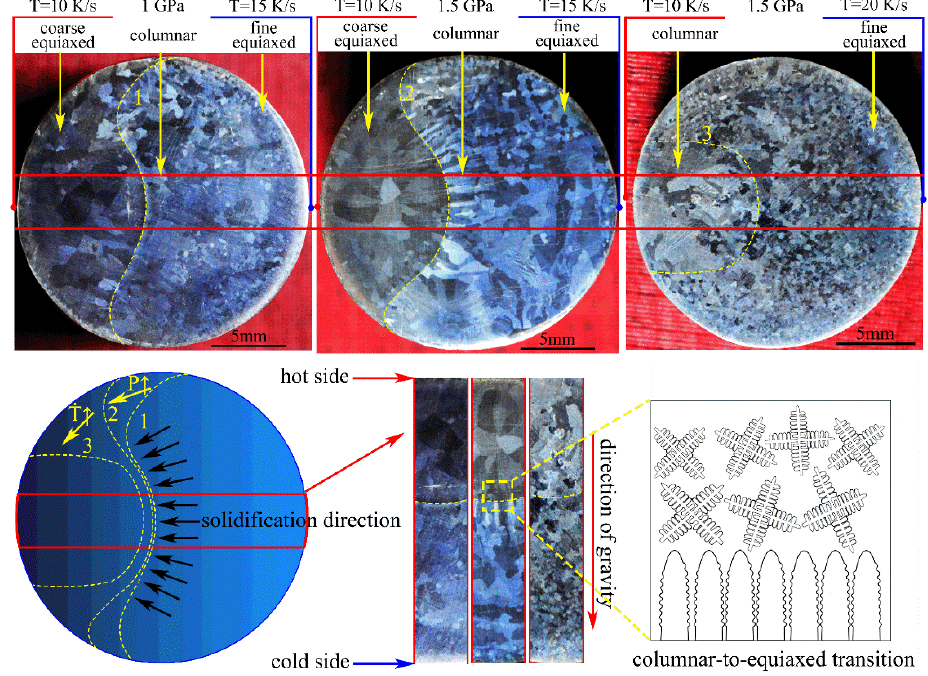
Figure 2. Macrostructures of the Mg-1Sn-2.5Y alloys solidified under high pressure and temperature gradient.